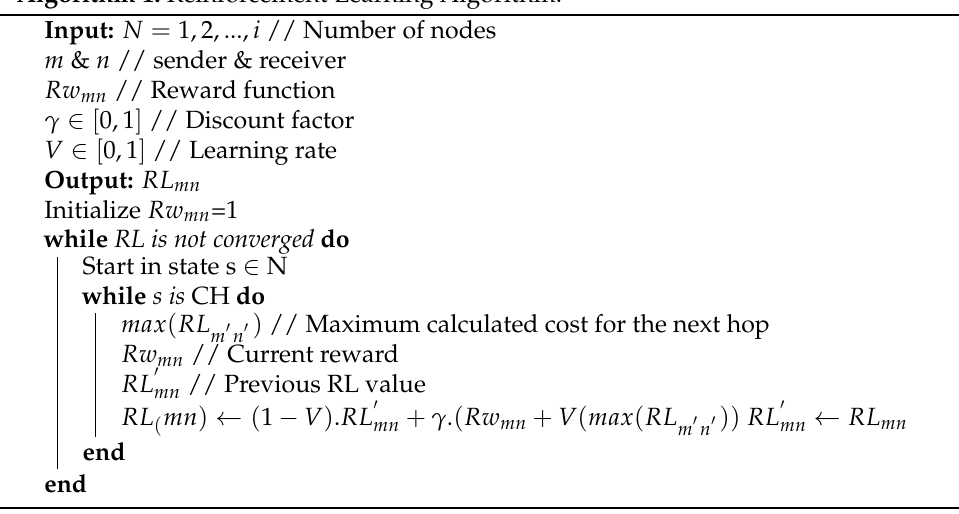
Algorithm 1: Reinforcement Learning